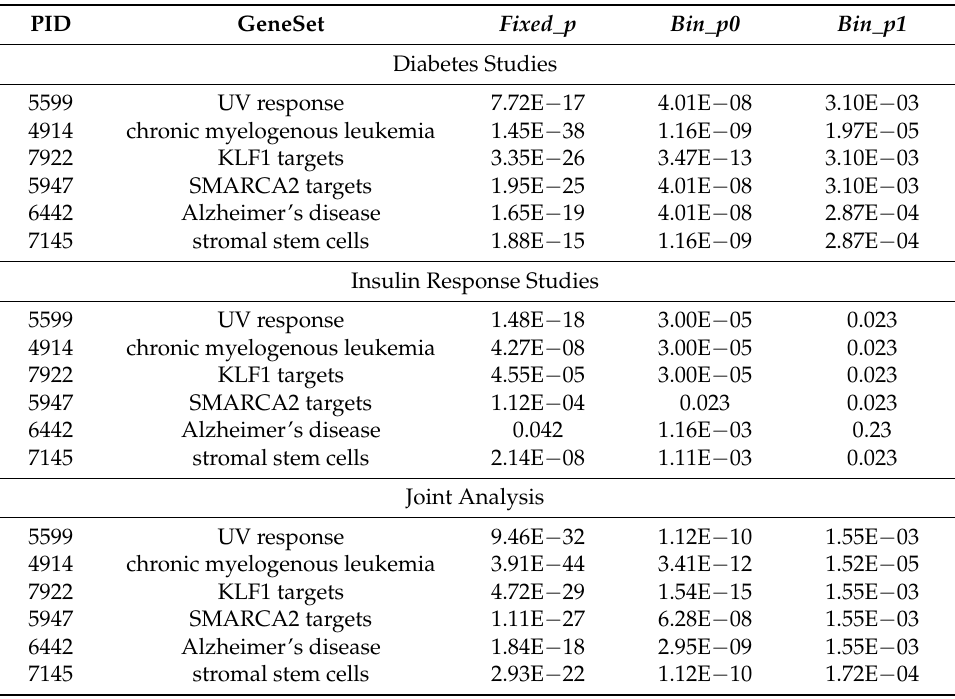
Table 3. Meta-analysis p -values of significant gene